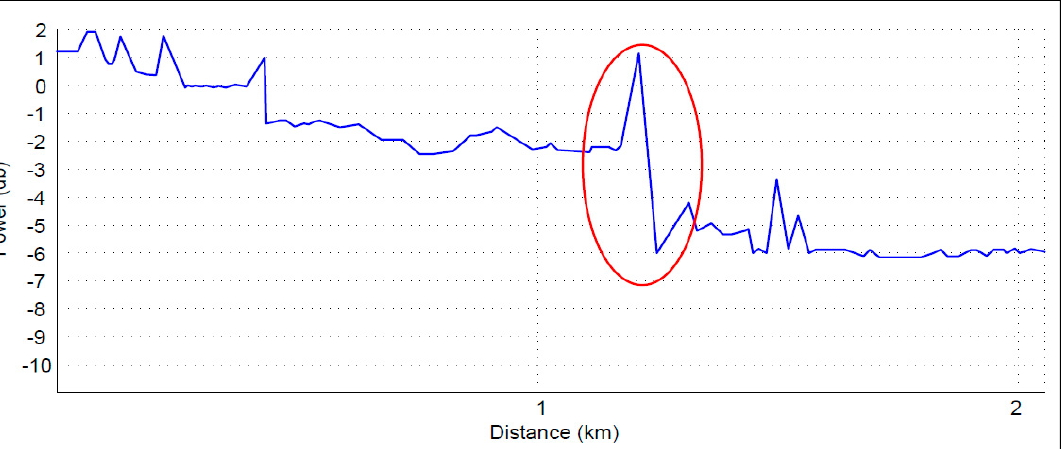
Figure 10. The improving FPMT circuit detected insertion loss on the connector pattern shape in event 4.